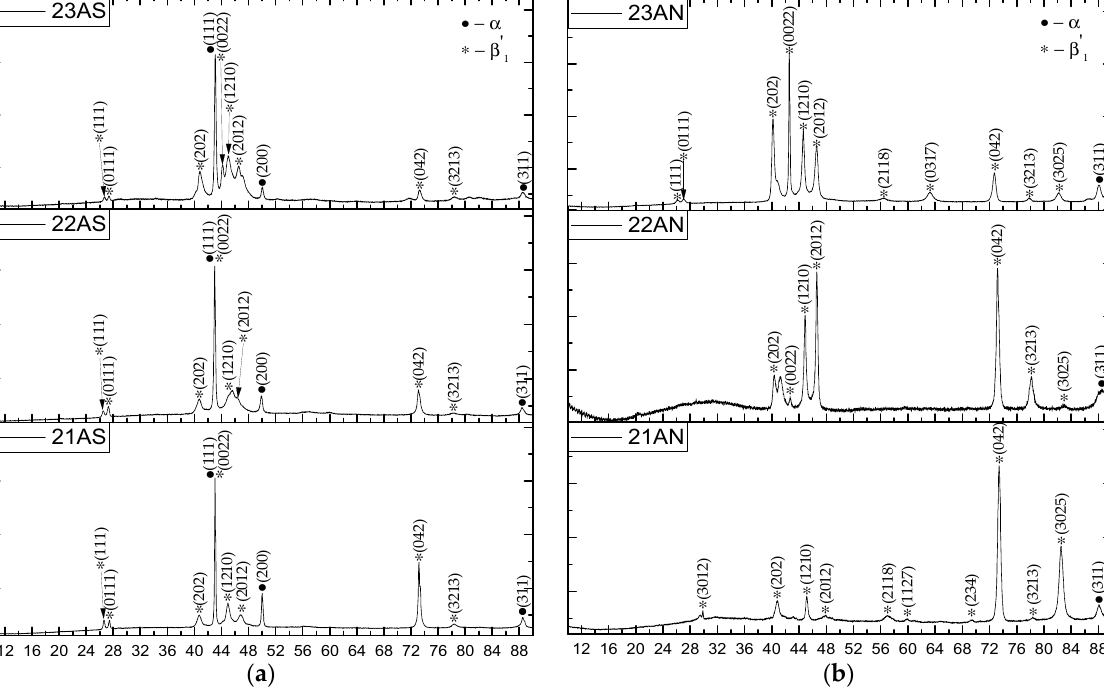
Figure 10. XRD diagrams of samples fabricated from Alloy 2: after printing ( a ), after annealing ( b ).